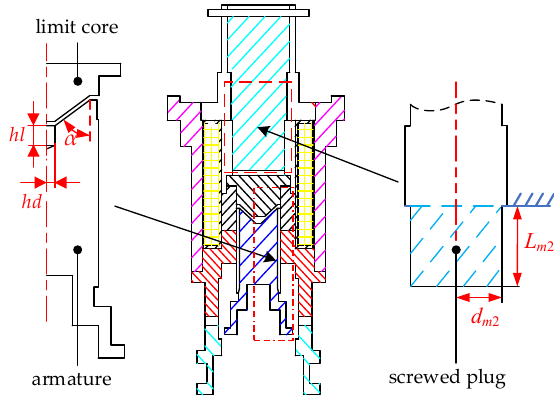
Figure 9. Key structural parameters of the HFSV.